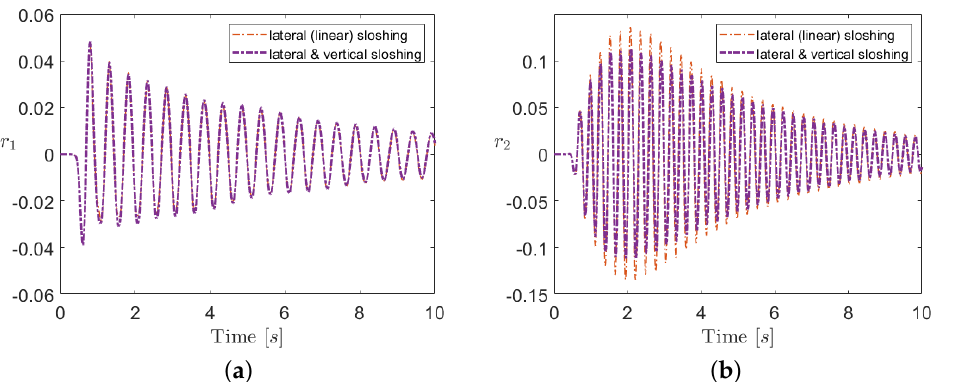
= 2.5m/s—Test Case 1. ( a ) First mode (dir. x). a